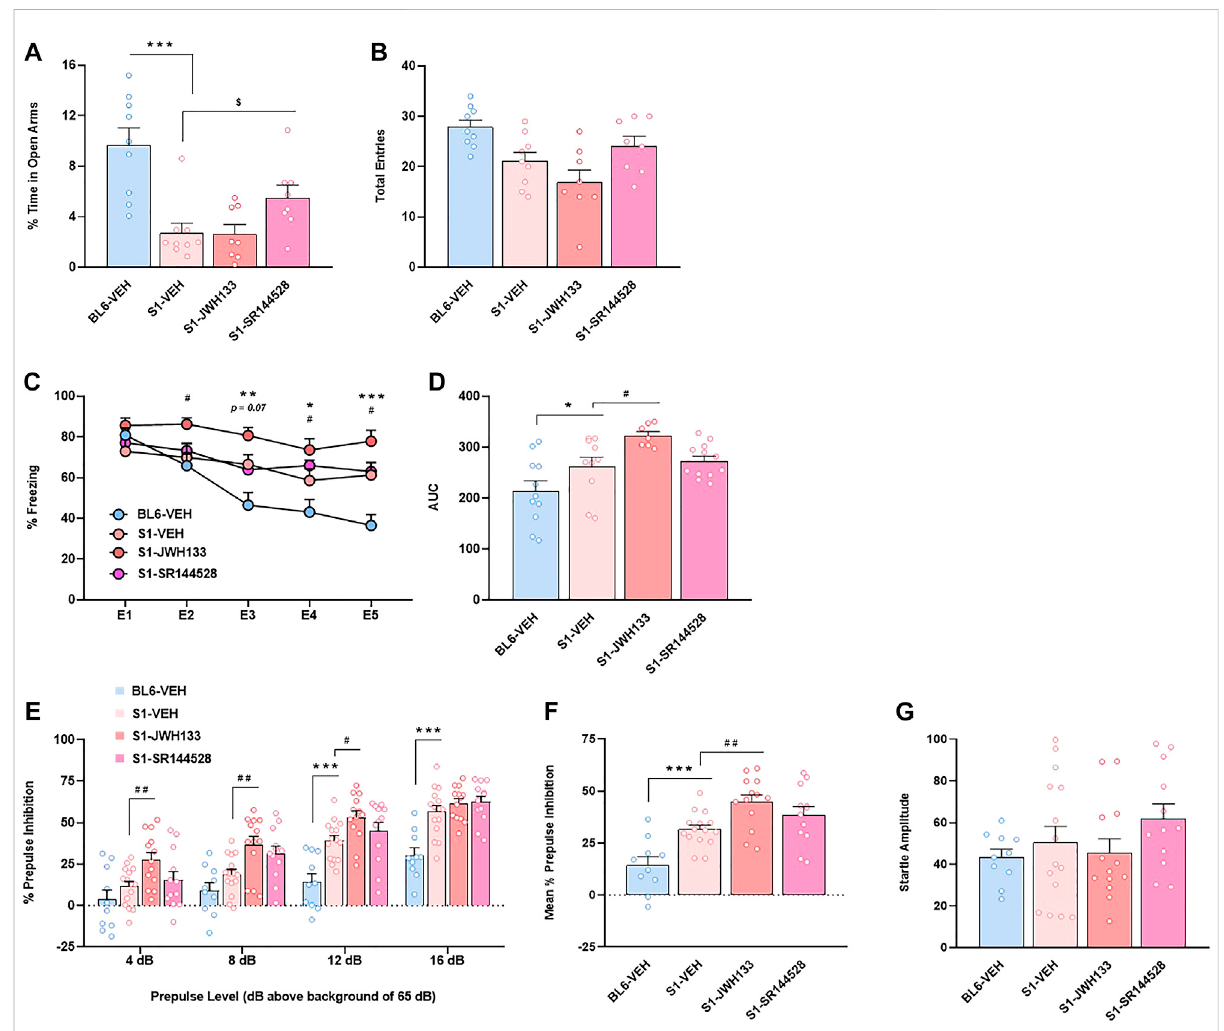
FIGURE 3 CB2R is involvedin the anxiety-like behavior, fearextinction de fi cits and increased prepulse inhibition response of theS1 mice strain compared to BL6 mice. (A,B) Percentage of time spent in the open arms (A) and total number of entries in both closed and open arms (B) of the elevated plus maze test in BL6 and S1 mice treated with theCB2R agonist JWH133 (5 mg/kg, ip) or the CB2R antagonist SR144528 (3 mg/kg, ip) 30 min before the test ( n = 8 – 9 mice per group). (C,D) Time course (C) and AUC values (D) of the freezing levels during cued fear extinction trials in BL6 and S1 mice treated with JWH133 (5 mg/kg, ip) or SR144528 (3 mg/kg, ip) 30 min before each extinction session ( n = 7 – 12 mice per group). (E – G) Percentageofprepulseinhibition (E) ,meanofthepercentageofprepulseinhibition (F) andstartleresponseamplitude (G) inBL6andS1micetreated with JWH133 (5 mg/kg, ip) or SR144528 (3 mg/kg, ip) 30 min before the test ( n = 10 – 15 mice per group). Data are expressed as mean ± SEM. * p < 0.05, ** p < 0.01, *** p < 0.001 (comparison between BL6-VEH and S1-VEH); $ p < 0.05 (comparison between S1-VEH and S1-SR144528); # p < 0.05, ## p < 0.01(comparisonbetweenS1-VEHandS1-JWH133).BL6:C57BL/6Jmicestrain;S1:129S1/SvImJmicestrain;E1-E5:extinctiontrials1 – 5;AUC: area under the